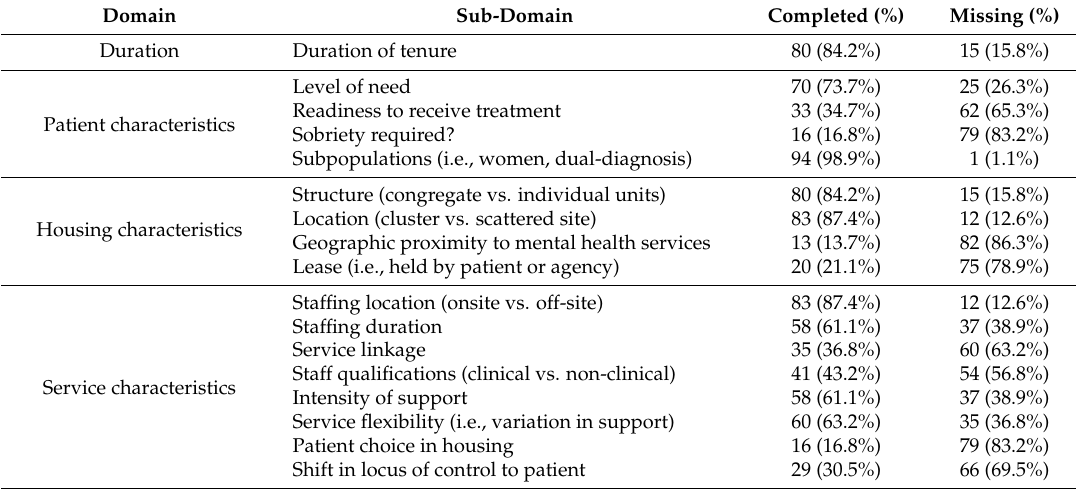
Table 4. DTSA: Missing data according to sub ‐ domain.